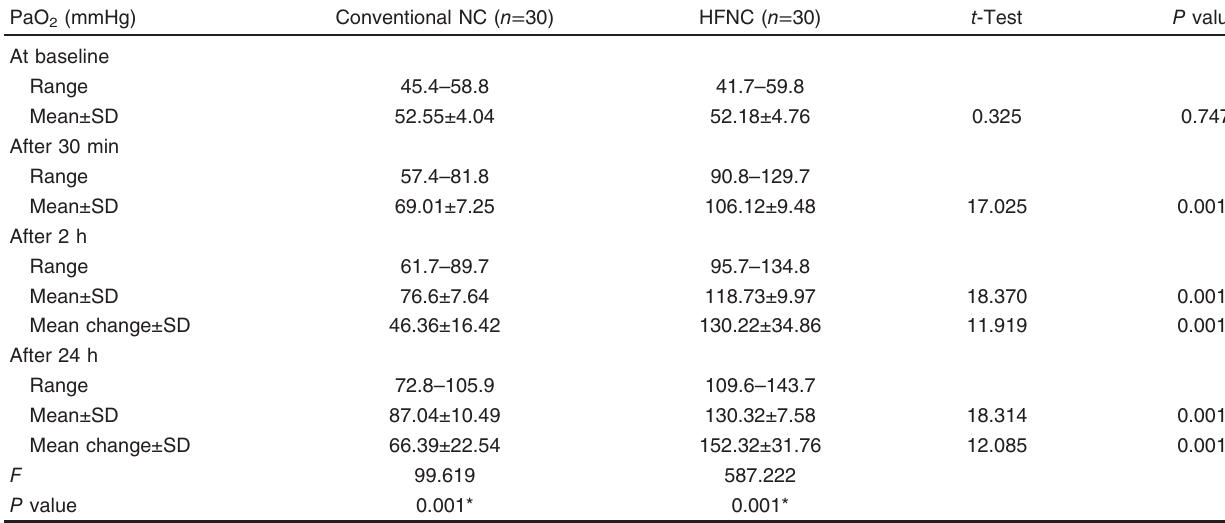
Table 7 Comparison of PaO 2 between the two studied